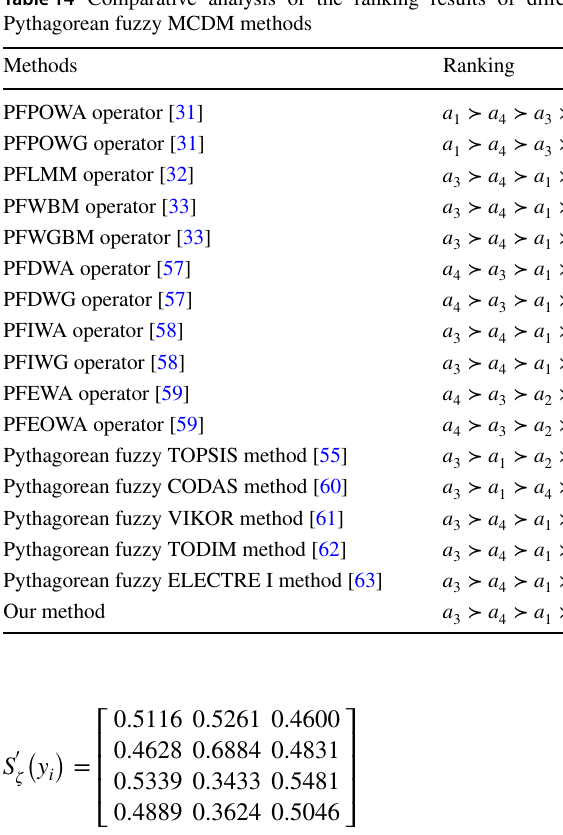
Table 14 Comparative analysis of the ranking results of